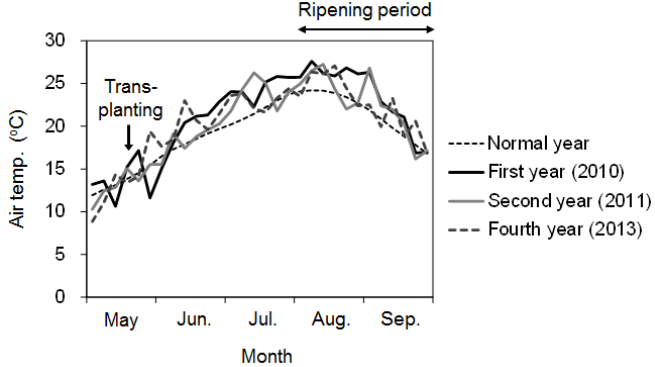
Figure 3. Time evolution of air temperature during the rice growing period for three years. The normal year is the average of the values for the past 30 years (1981–2010). The average values of every five days are shown.